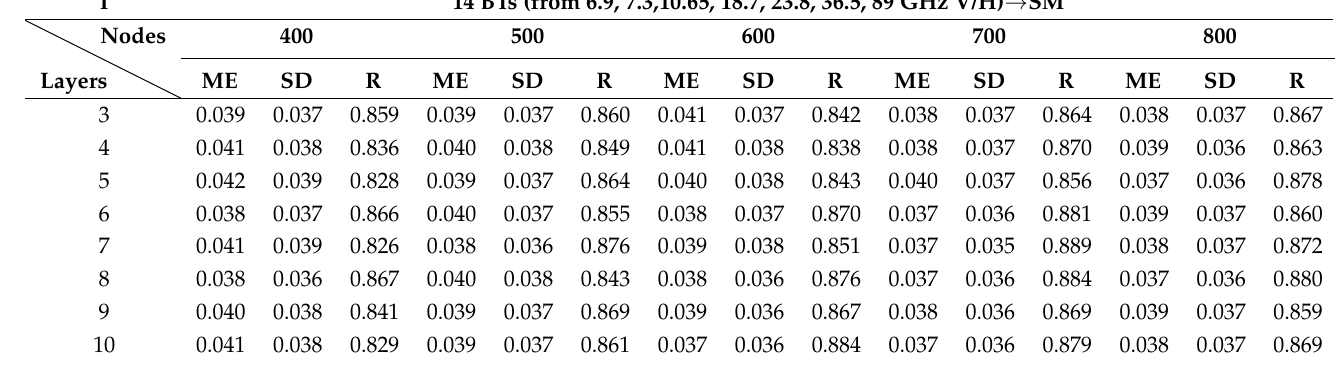
Table 1. Fourteen channels are used to retrieve SM (brightness temperature combination of fourteen channels).